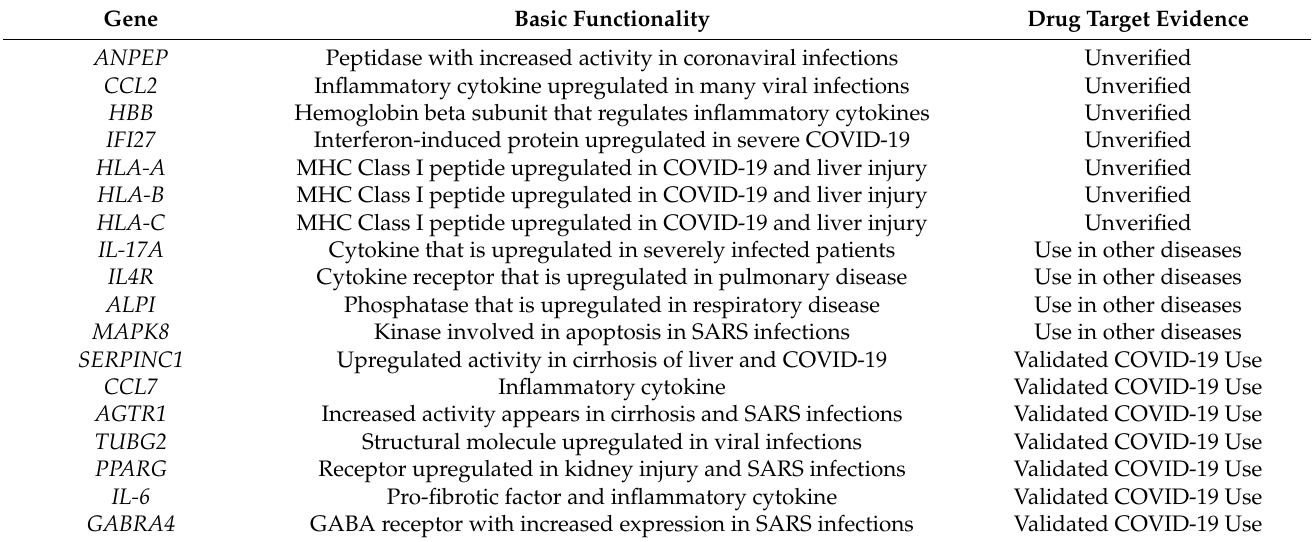
Table 3. Potential Therapeutic Targets. Possible COVID-19 therapeutic targets based on targetability in similar diseases and prevalence in COVID-19